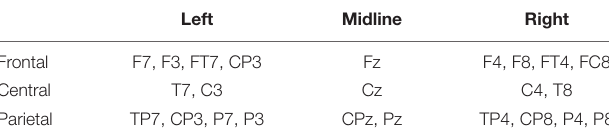
TABLE 3 | Electrodes chosen for data